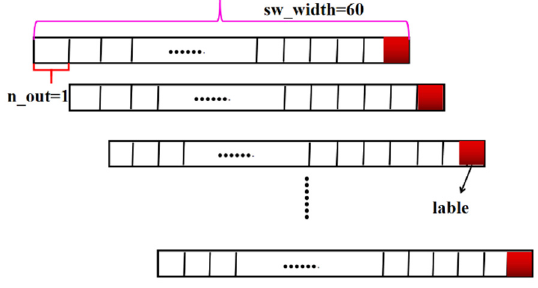
Figure 8. Division of the datasets.